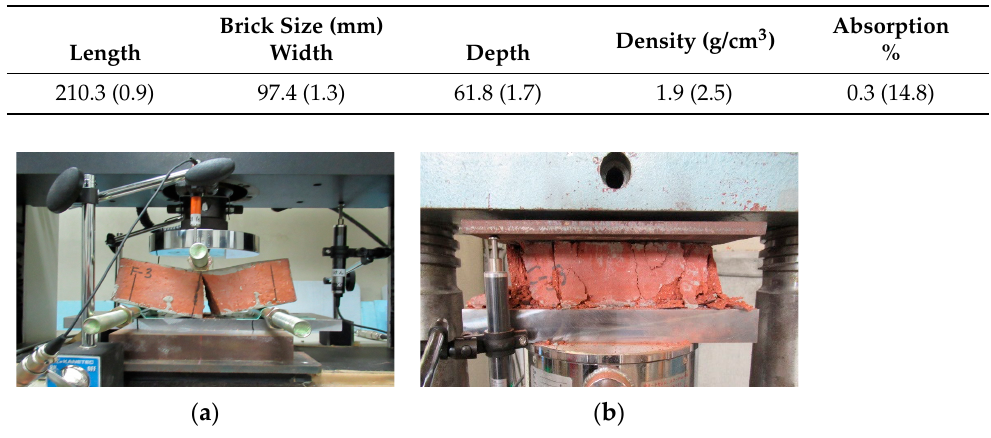
Table 1. The dimension, density, and absorption of brick (mean of 10 bricks).